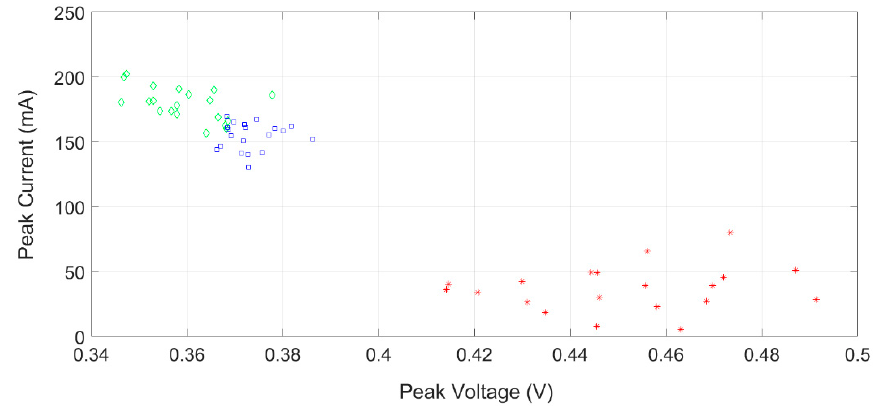
Figure 2. Peak potential and currents measured on several cyclic voltammograms executed on the hydroquinone pollutant (5 mM), with different platforms: Bare SPEs (green), MWCNT SPEs (blue), and SWCNT SPEs (red).